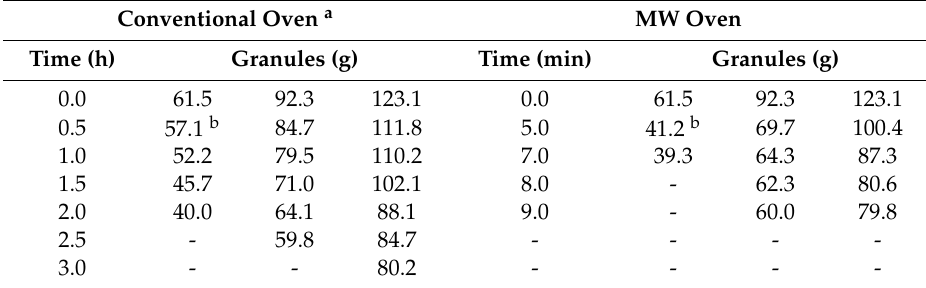
Table 1. Results of heating of ODTMA–clay wet granules (65% solid) in an ordinary oven (110 °C) and in MW oven (80–100 °C).